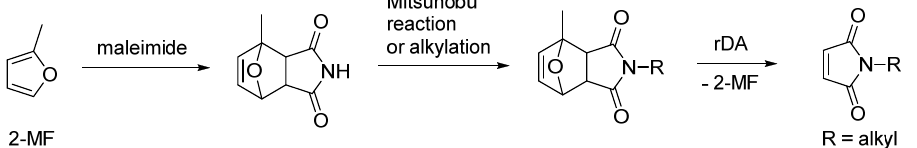
Scheme 3. Synthesis of N -substituted maleimides from 2-MF and maleimide using the DA approach. Representative reactions of 2-MF with acyclic alkenes containing one or two electron- withdrawing groups (EWGs) are covered in Table 2. High endoselectivity was obtained